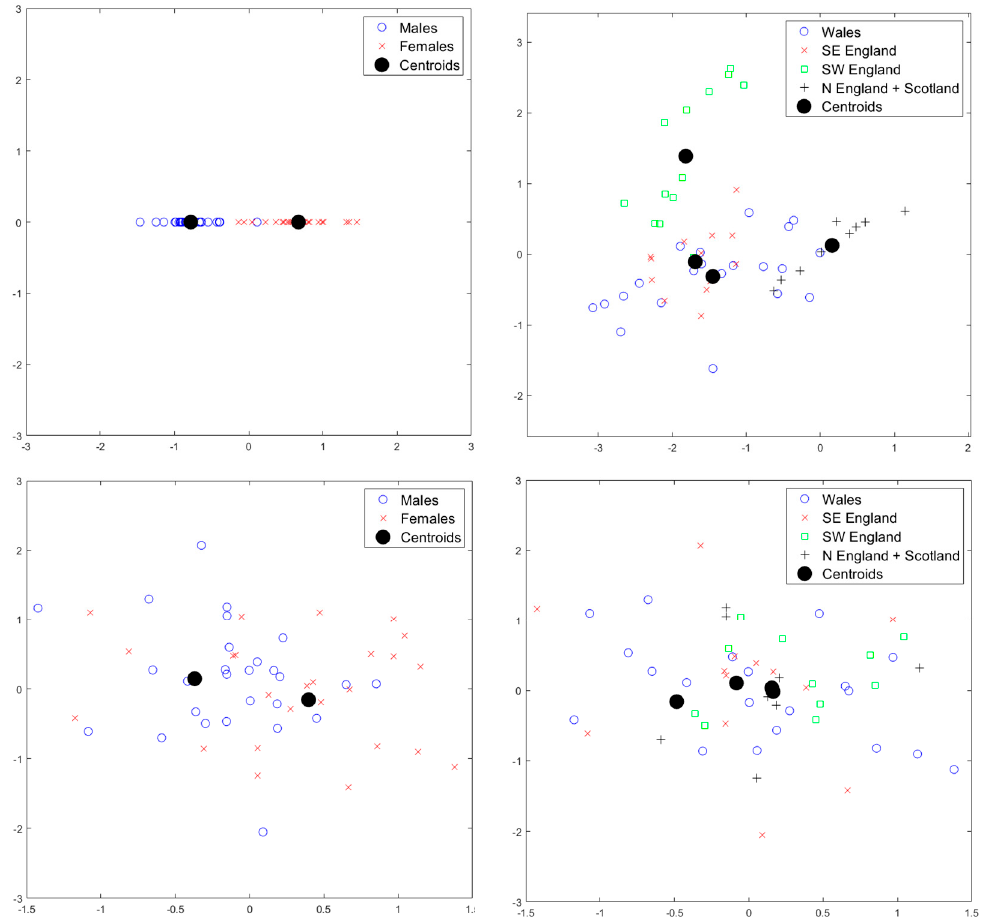
Figure 9. The results of mPCA for standardized component scores ( x -axis: component 1; y -axis: component 2) for the scaled shape data. Results of mPCA with m 1 = 1; m 2 = 3; m 3 = 20 in Equation (A4) are shown in the top row: ( left ) level 1, which shows a strong clustering by sex; ( right ) level 2, which shows clustering by geographical area. Results of single-level PCA are shown in the bottom row: ( left ) symbols chosen by sex; ( right ) symbols chosen by geographical area.